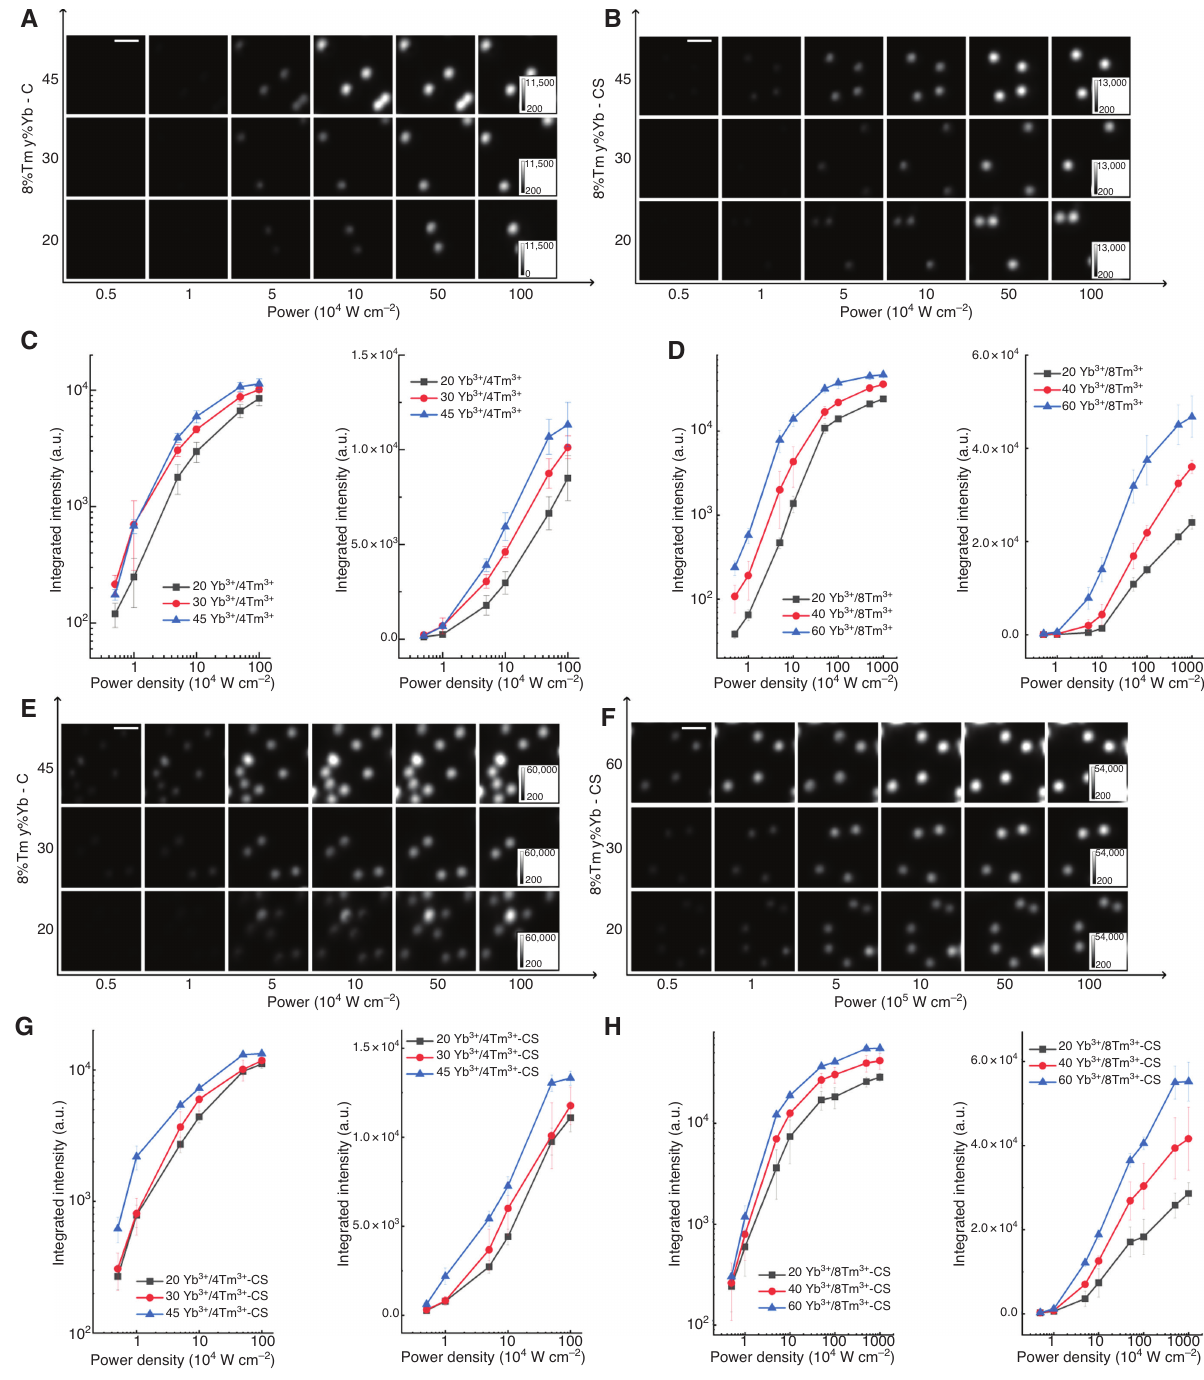
Figure 2: Microscopy quantitative measurement of the whole upconverting spectrum luminescence emission. (A) single 4% Tm 3 + UCNPs vs. Yb 3 + concentration, (B) single 8% Tm 3 + UCNPs vs. Yb 3 + concentration, (E) single 4% Tm 3 + core-shell UCNPs vs. Yb 3 + concentration, and (F) single 8% Tm 3 + core-shell UCNPs vs. Yb 3 + concentration. The power-dependent saturation curves of (C) single 4% Tm 3 + UCNPs vs. Yb 3 + concentration, (D) single 8% Tm 3 + UCNPs vs. Yb 3 + concentration, (G) single 4% Tm 3 + core-shell UCNPs vs. Yb 3 + concentration, and (H) single 8% Tm 3 + core-shell UCNPs vs. Yb 3 + concentration. The saturation curves under different power densities from 5 kW/cm 2 to 10 MW/cm 2 obtained with large field PMT detector-based LSM. A log scale is used for the y -axis in the left panels of (C and D) and (G and H), and a linear y -scale is employed in the right panels of (C and D) and (G and H). Scale bar, 1 μ m; pixel dwell time, 200 μ s. Error bars represent standard deviation from the